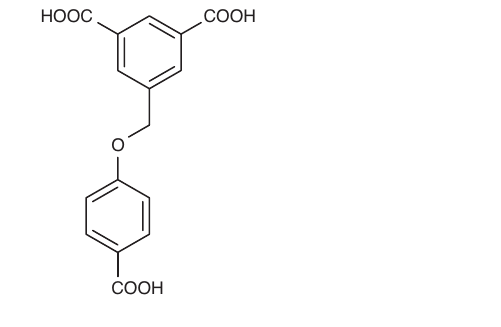
Figure 1: Chemical structure of the H